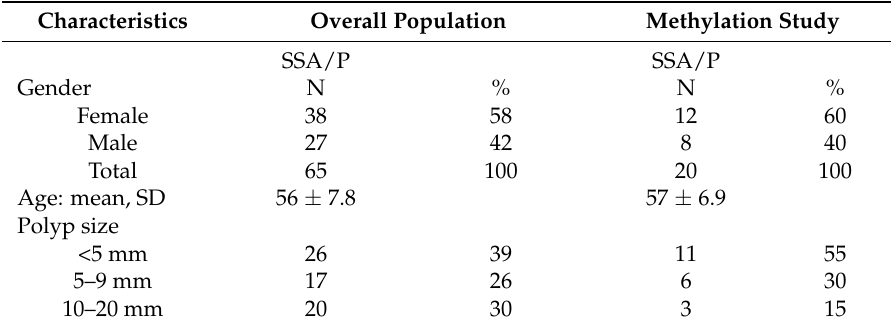
Table 1. Characteristics of New Hampshire (NH) Colonoscopy Registry patients with right-sided sessile serrated adenomas/polyps